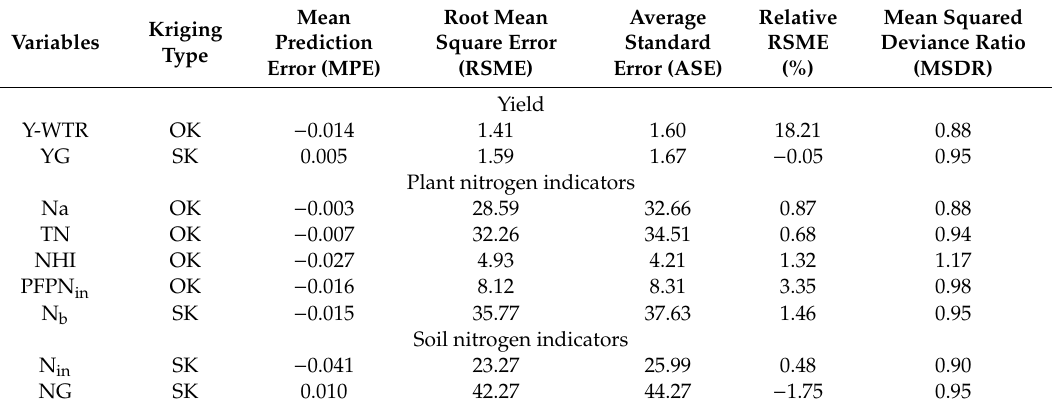
Table 10. Summary statistics of ordinary or simple